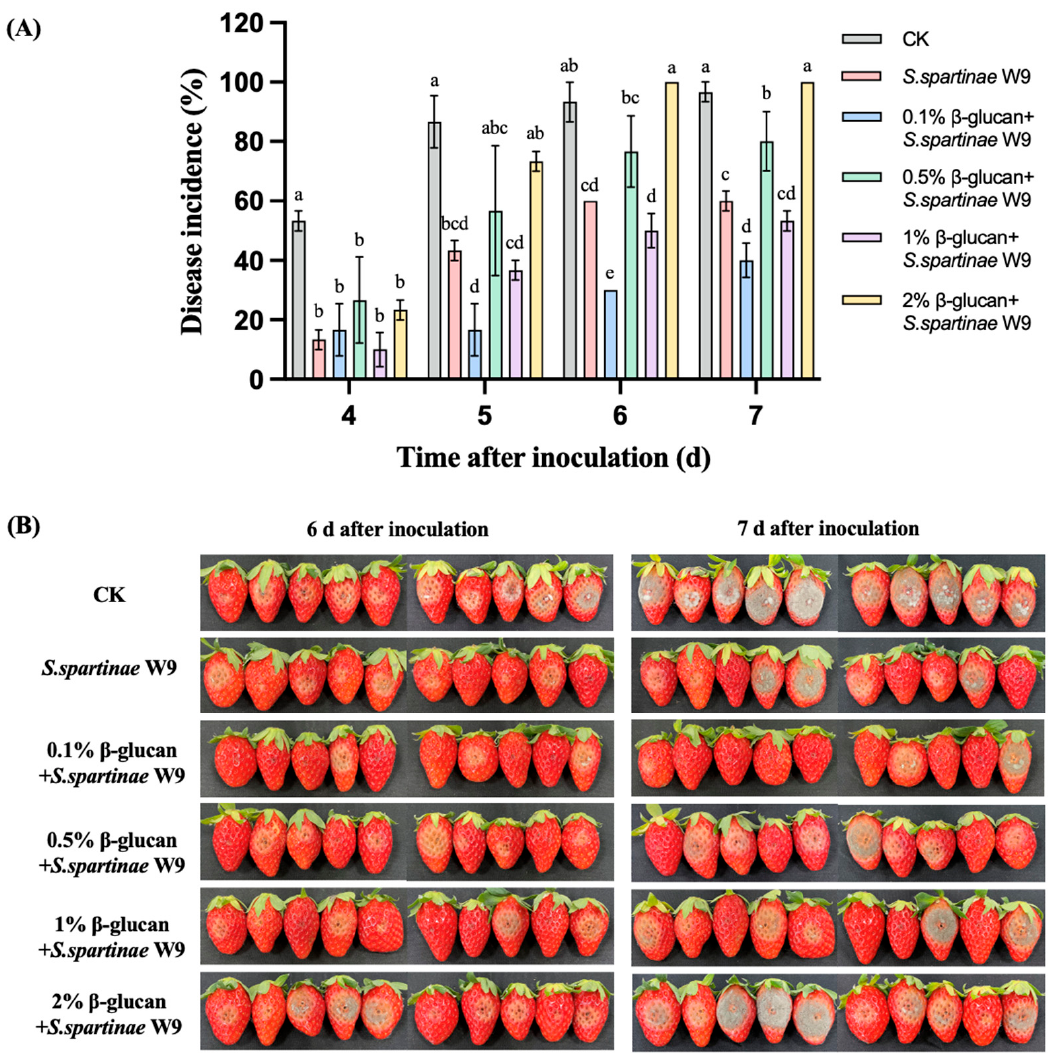
Figure 1. Biocontrol efficacy of S. spartinae W9 cultured with different concentrations of β -glucan against B. cinerea in strawberries. ( A ) Disease incidence of gray mold in strawberries after the treatment with S. spartinae W9 cultured with different concentrations (0, 0.1%, 0.5%, 1%, and 2%) of β -glucan during storage. ( B ) Phenomenon of gray mold in strawberries in each group at day 6 and day 7 after inoculation with B. cinerea . Different lowercase letters indicate significant differences between different treatment groups according to Duncan’s test ( p < 0.05).